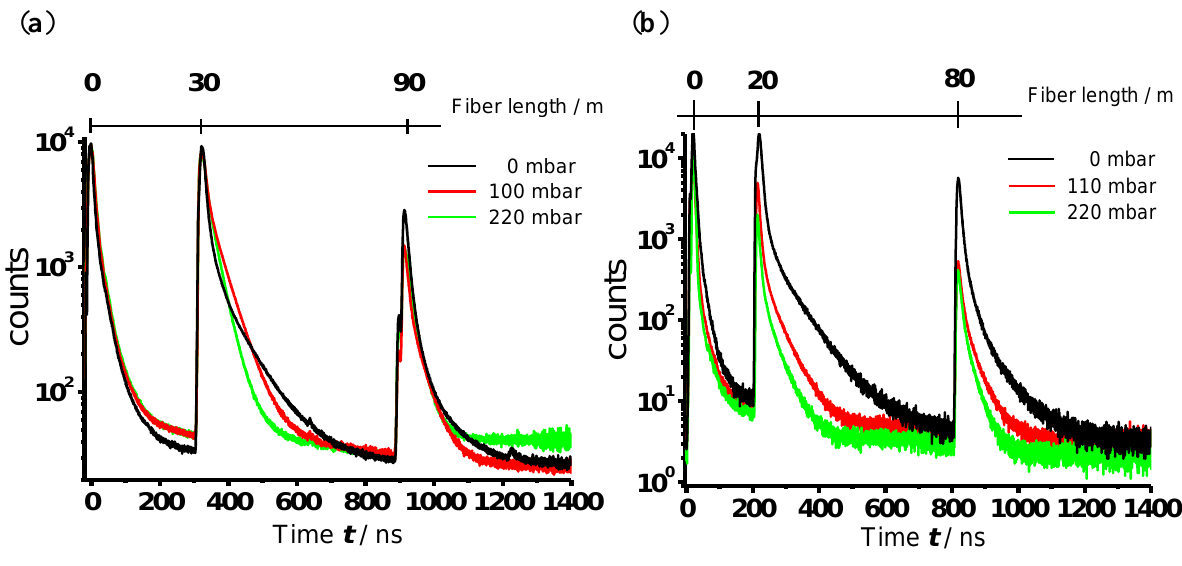
Figure 6. OTDR traces of different oxygen concentrations of ( a ) the branched fiber model ( b ) the single linear fiber model for the evanescence wave application.